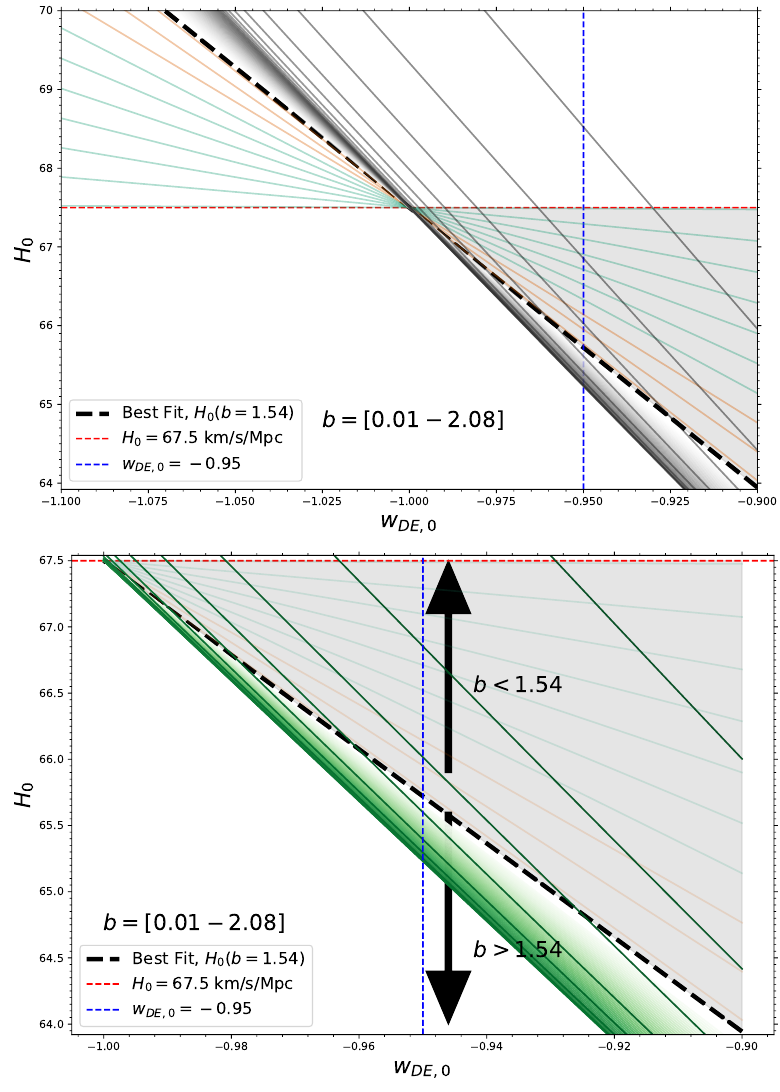
Figure 3. ( Up ): Value of H 0 plotted against the current day w DE values for a family of b values. The lines are demarcated into two broad groups, one b < 1.54 (coloured lines) the other b > 1.54 (grey tone lines), separated by the b = 1.54 line, shown in broad black dashed line, which corresponds to the best fit b value. ( Down ): A zoomed in plot of the left figure. The corresponding grey toned lines (for b > 1.54 case) are shown in green tone lines here. We observed that, for low b values, the evolution of the Hubble constant value at the present time had a minimum correlation to the current dark energy parameter constraint. As b is increased, the tilt in the H 0 − w DE ,0 relation increases toward a more positive correlation. The blue vertical dashed line marks the w DE ,0 value from our model. For very low values of b or for b > 2.065, the H 0 values come closest to the current observed H 0 = 67.5 km/s/Mpc